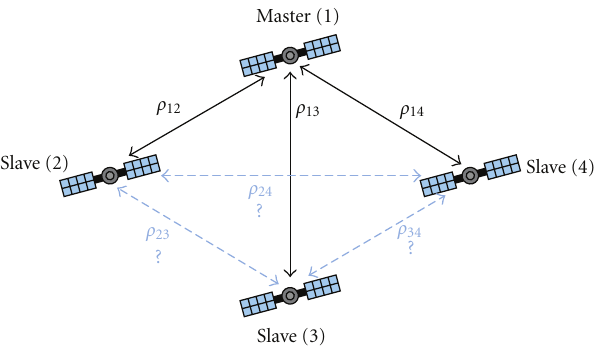
Figure 2: Master-Slave approach for multisatellite modelling. Several slave satellites are modelled according to the correlation to one master satellite, while neglecting the correlation between the slave satellites. The Master-Slave method has a reduced complexity compared to the conventional approach, where each individual correlation is